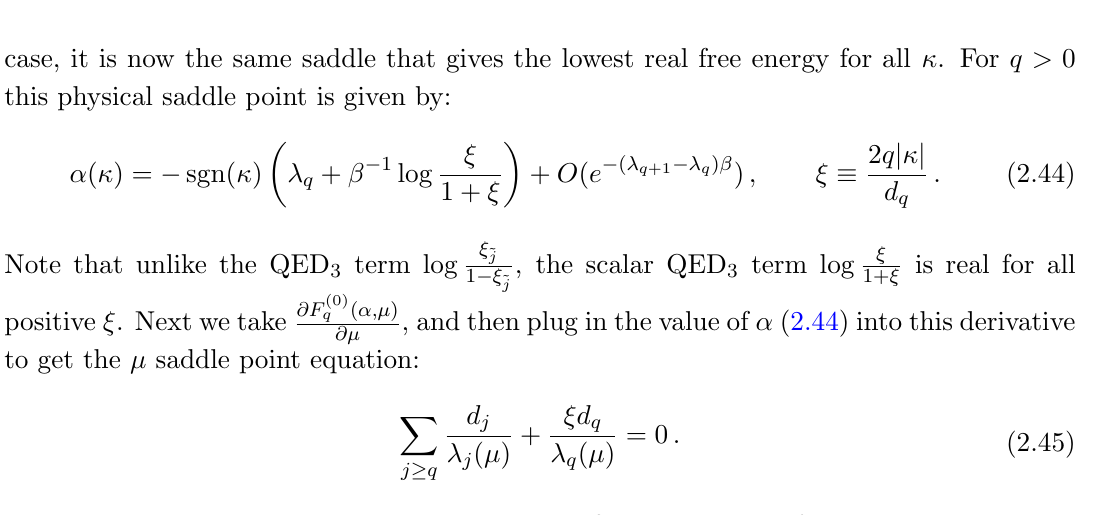
Figure 3 . Top : the leading order coe(cid:14)cients (cid:1) (0) q and S (0) q of the scaling dimension and entropy of the lowest-dimension monopole operators 1 = 2 (cid:20) q (cid:20) 2 in scalar QED 3 , as a function of (cid:20) (cid:17) k=N . The exact value (cid:1) (0) = 1 at j (cid:20) j = 1 is explained in (2.47). Bottom : the saddle point value of the 1 = 2 Lagrange multiplier (cid:22) as a function of (cid:20) . Note that (cid:22) ( (cid:20) ) is not exactly